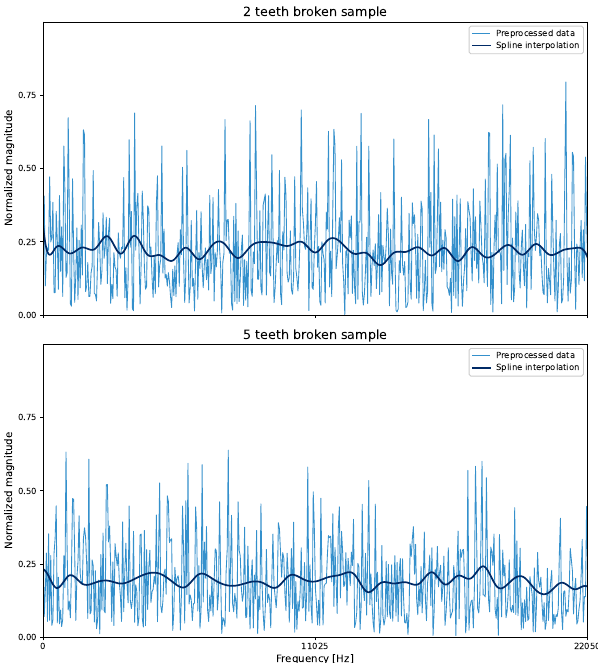
Figure 8. Two samples of recordings from different groups of faulty drills. Each chart combines a sample after preprocessing and the same sample after approximation by basis spline